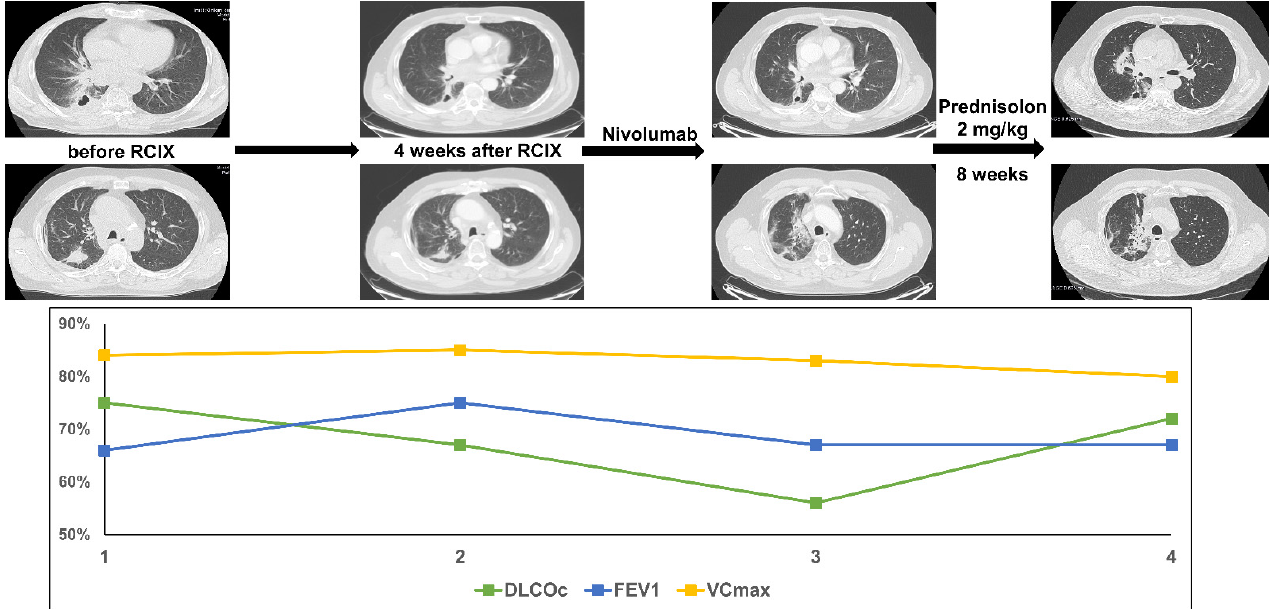
Figure 5. The figure shows course of treatment, corresponding CT imaging and lung function values of patient 5. (RCIX: Radiochemoimmunotherapy).